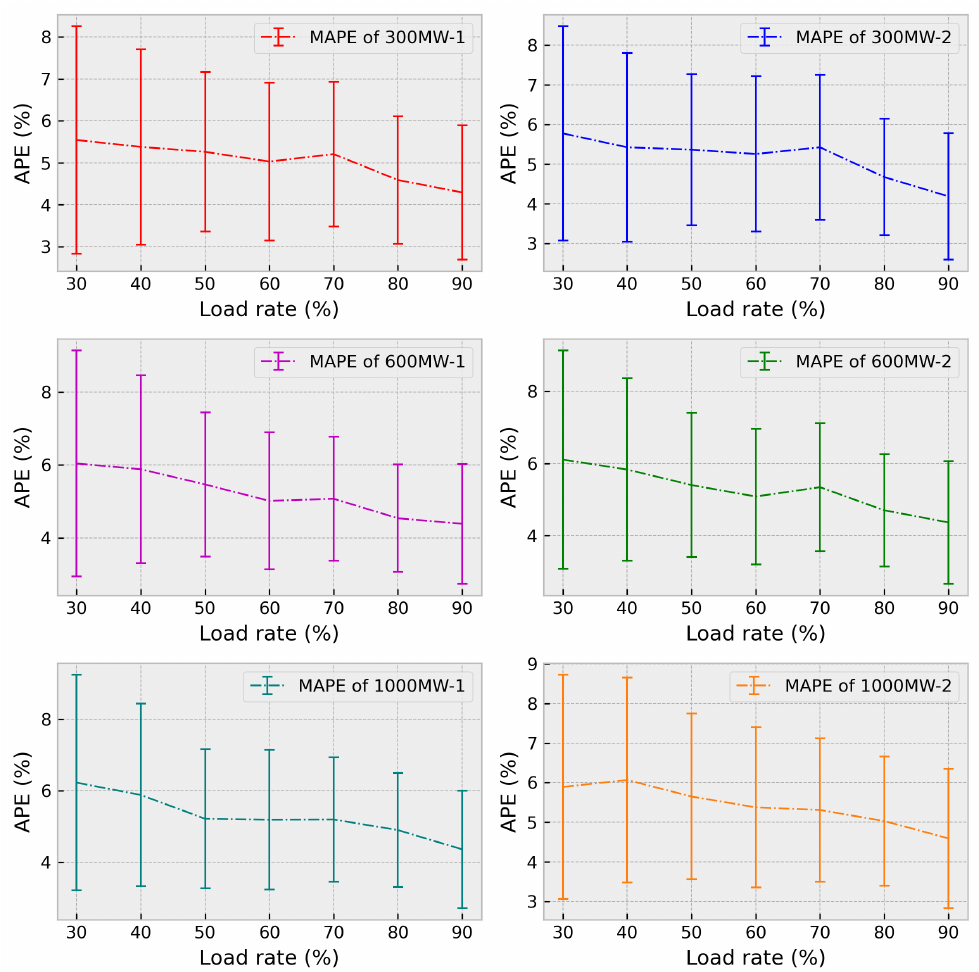
Figure 18. Analysis of the uncertainty of EEN according to estimated hourly CO 2 emissions at varying load